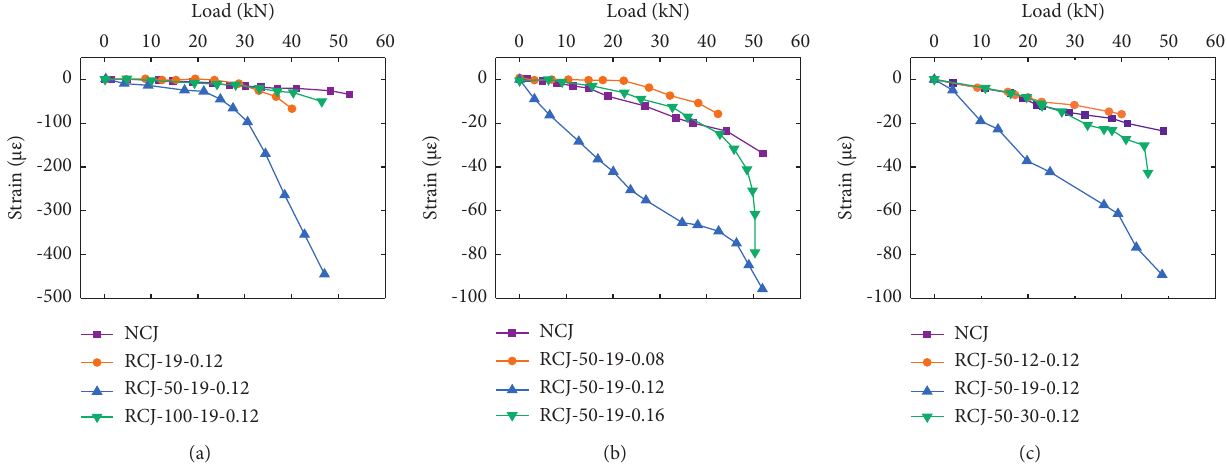
Figure 15: Comparison of influencing factors of stirrup strain-load curve. (a) Replacement rate of RCA. (b) Volume of waste fibers. (c) Length of waste